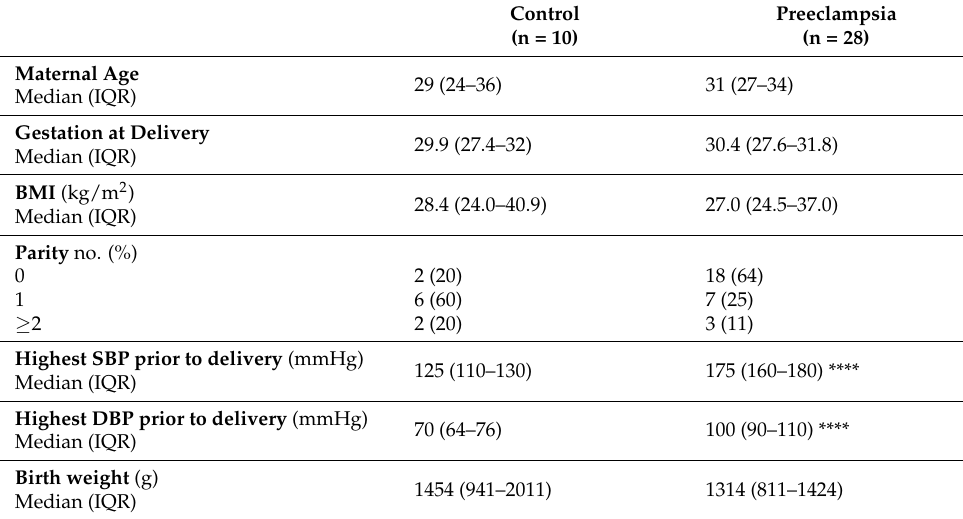
Table 2. Patient characteristics for collected placental tissue